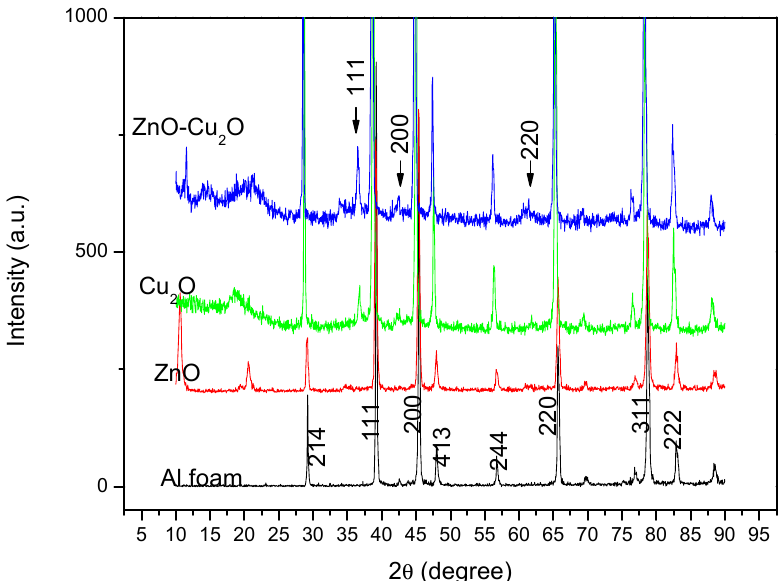
Figure 2. The XRD of aluminum (Al) foam, ZnO, Cu 2 O and ZnO-Cu 2 O sample.